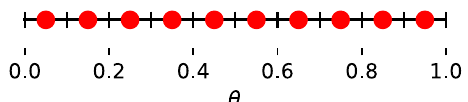
Fig. 1 For some applications, training data are only available at dis- crete values of θ (e.g. at each of the red markers). For every example discussed here, the training samples consist of 10 template data sets with parameter θ equally spaced between 0 and